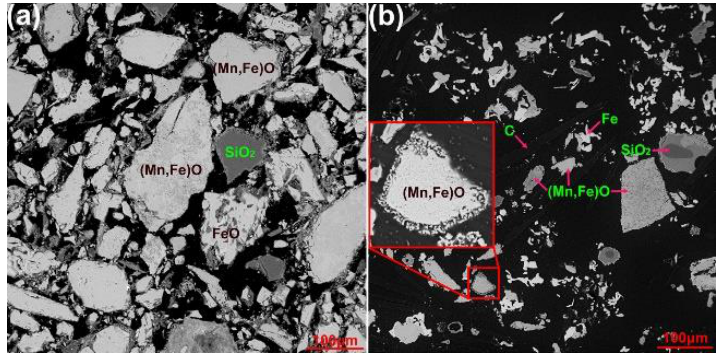
Figure 6. BSE images of the sample products collected after reduction at 1000 °C for ( a ) 2 h and ( b ) 4 h.